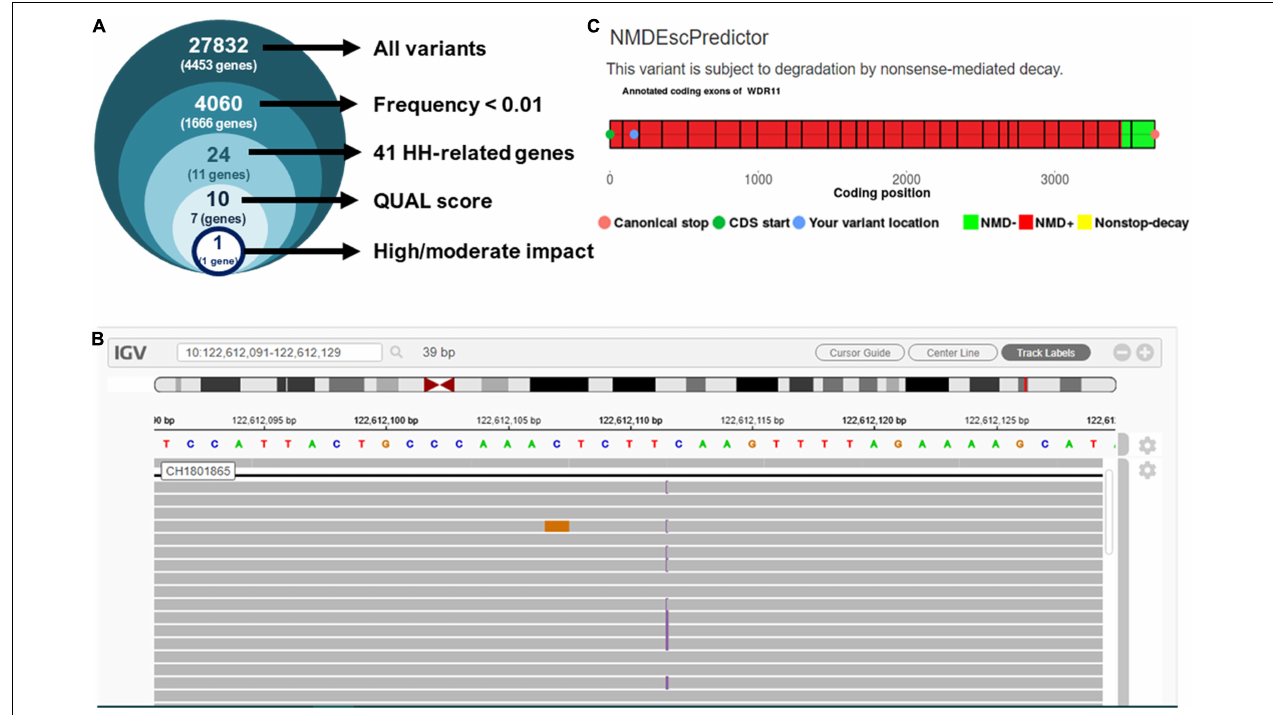
FIGURE 2 | Analysis of next-generation sequencing results. (A) Prioritization of variants found in the proband by targeted exome NGS. (B) Integrative Genome Viewer (IGV) visualization of variant NM_018117.12:c.163dup, p.(Gln55Pro fs7*). (C) Prediction of nonsense-mediated decay using NMDEscPredictor.